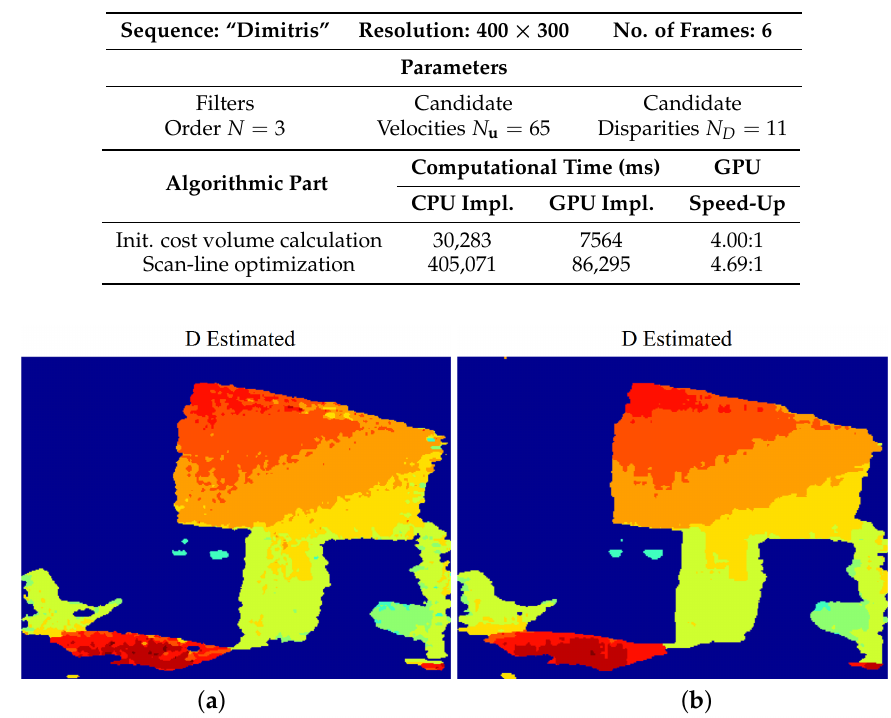
Table 4. Parameters and computational time (CPU vs. GPU) for the “Dimitris-Chessboard” sequence.